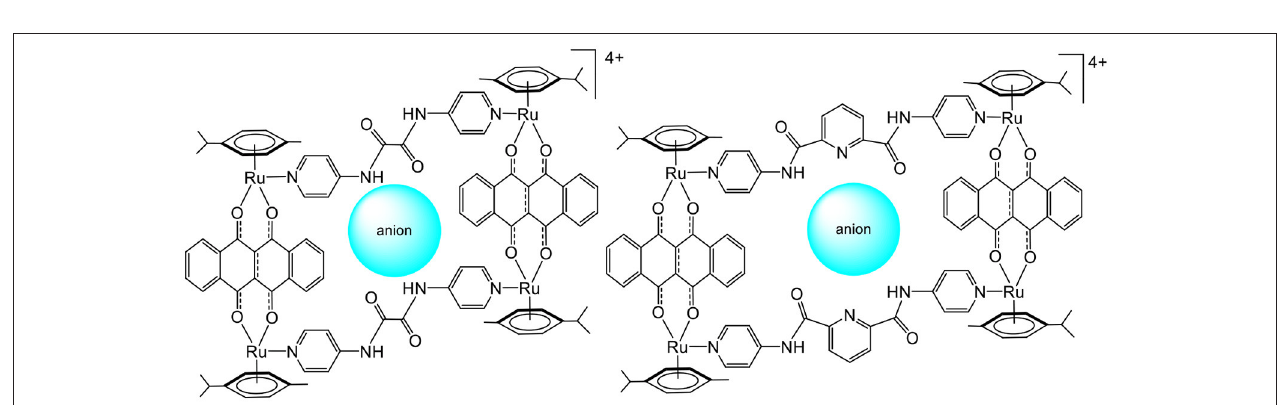
FIGURE 1 | Sensing of MCI (M = Li, Na, K) in a trinuclear arene ruthenium metalla-cycle (Piotrowski et al., 2001).